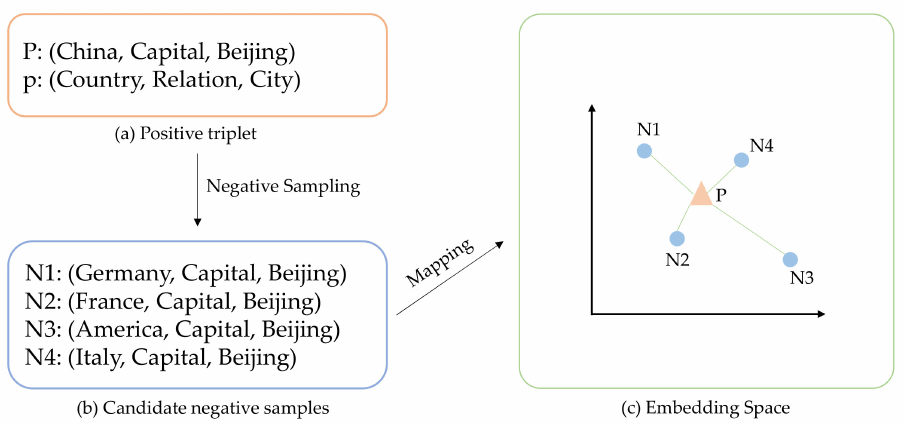
Figure 6. An example of negative sampling. There is a positive triplet in ( a ), and ( b ) shows the candi‑ date negative samples in the cache, which are generated by negative sampling of the positive triplet. ( c ) represents the embedded space. ▲ denotes the positive triplet, • denotes the negative triplet.